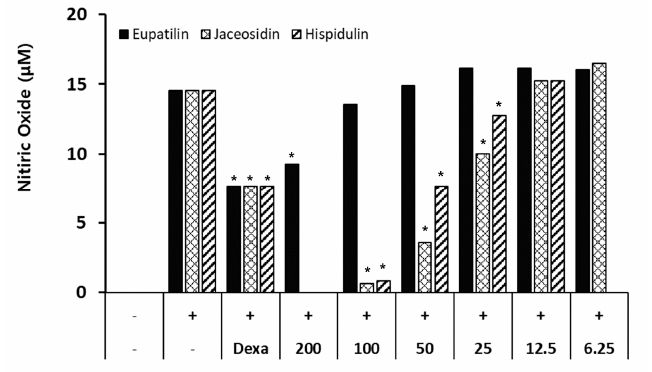
Figure 2. The inhibitory effects of eupatilin, jaceosidin and hispidulin on nitric oxide production in LPS-stimulated RAW264.7 cells; ( − ): vechicle group (0.1% DMSO-treated group), (+): positive control group (500 ng/mL of LPS treatment for 20 h), Dexa: dexamethasone for 2 h and then incubated with LPS for 20 h. Cells were treated with eupatilin or jaceosidin or hispidulin for 2 h and then incubated with LPS for 20 h. Results are expressed as mean ± SD of triplicate experiments. Statistical significance was determined using one-way analysis of variance (ANOVA) followed by Tukey’s post hoc test. * p < 0.001 vs. LPS treated group.